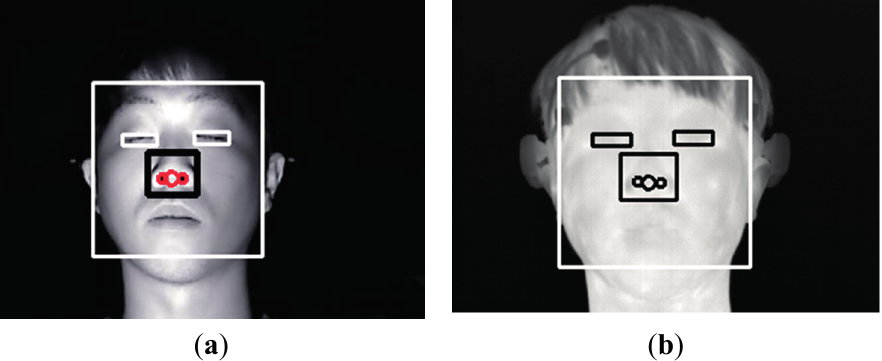
Figure 6. ( a ) Detected face and facial feature regions in the visible-light image; ( b ) mapped face and facial feature regions in the thermal image after geometric